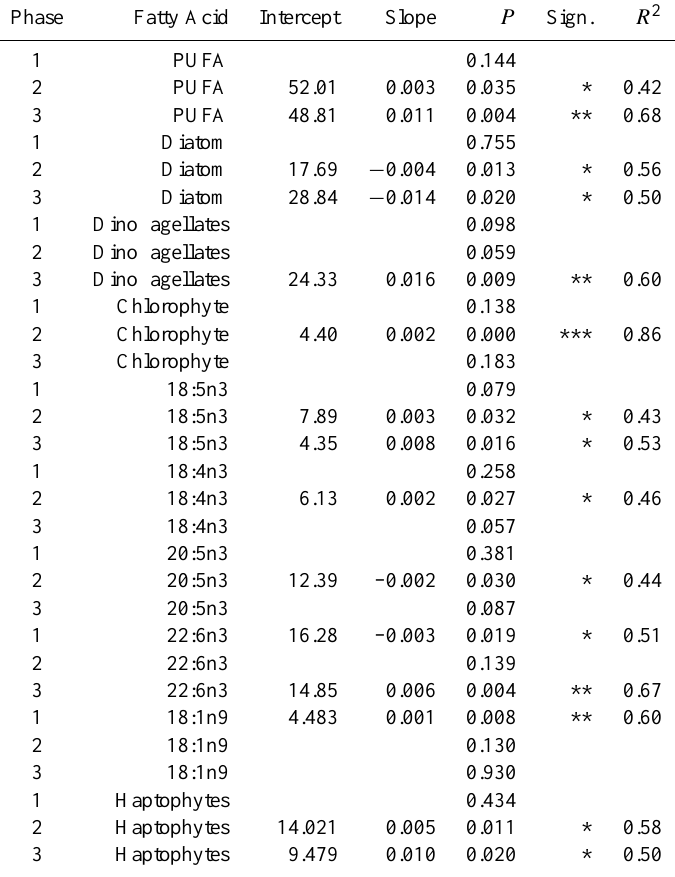
Table 2. Linear regression analyses of fatty acid markers (%) against p CO 2 (µatm) in different phases of the experiment. Proportion of different fatty acids markers and p CO 2 levels were averaged over the time period of the three phases: Phase 1= day − 4 to 12, Phase 2= day 13 to 21, Phase 3 = day 22 to end. Entries in the Table give the estimates for the intercept and the slope, the R 2 value and the statistical significant level given as p values and indicated as *** p < 0 . 001, **0.001 < p < 0 . 01, *0.01 < p <